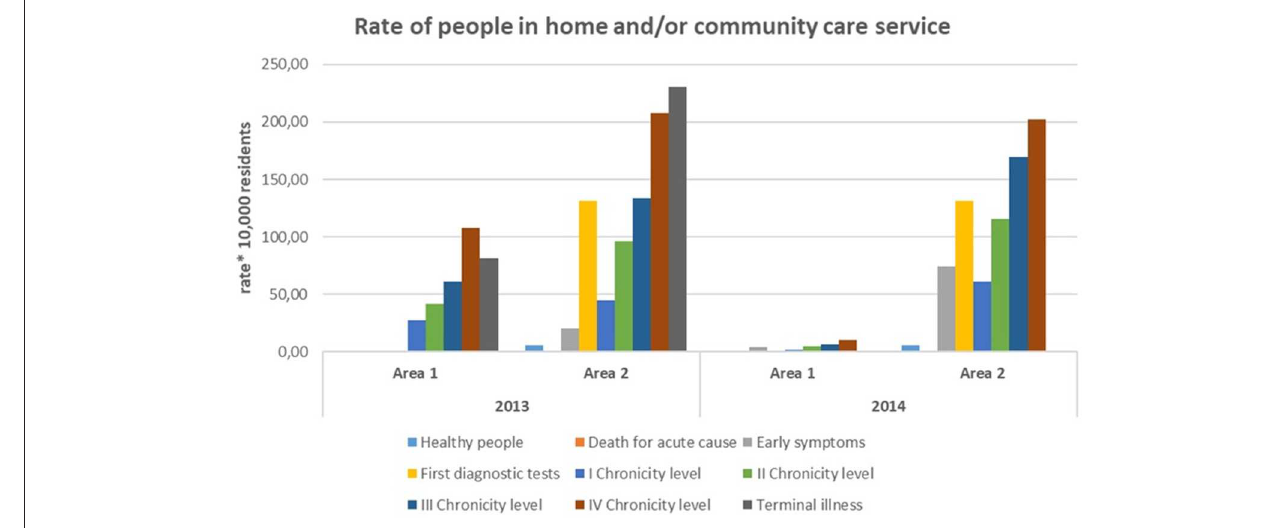
FIGURE 7 | Rate of people in home and/or community care service.